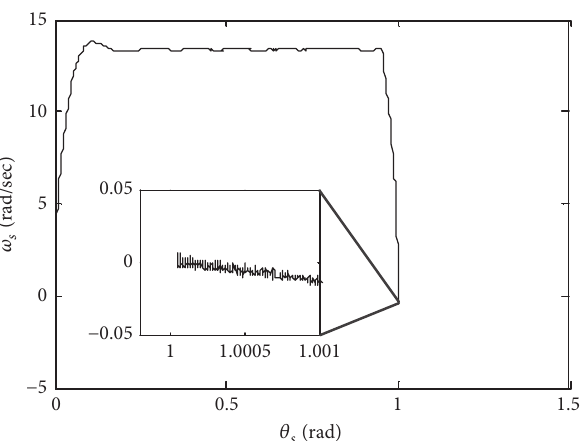
Figure 5: The phase trajectory under SMC-controller.